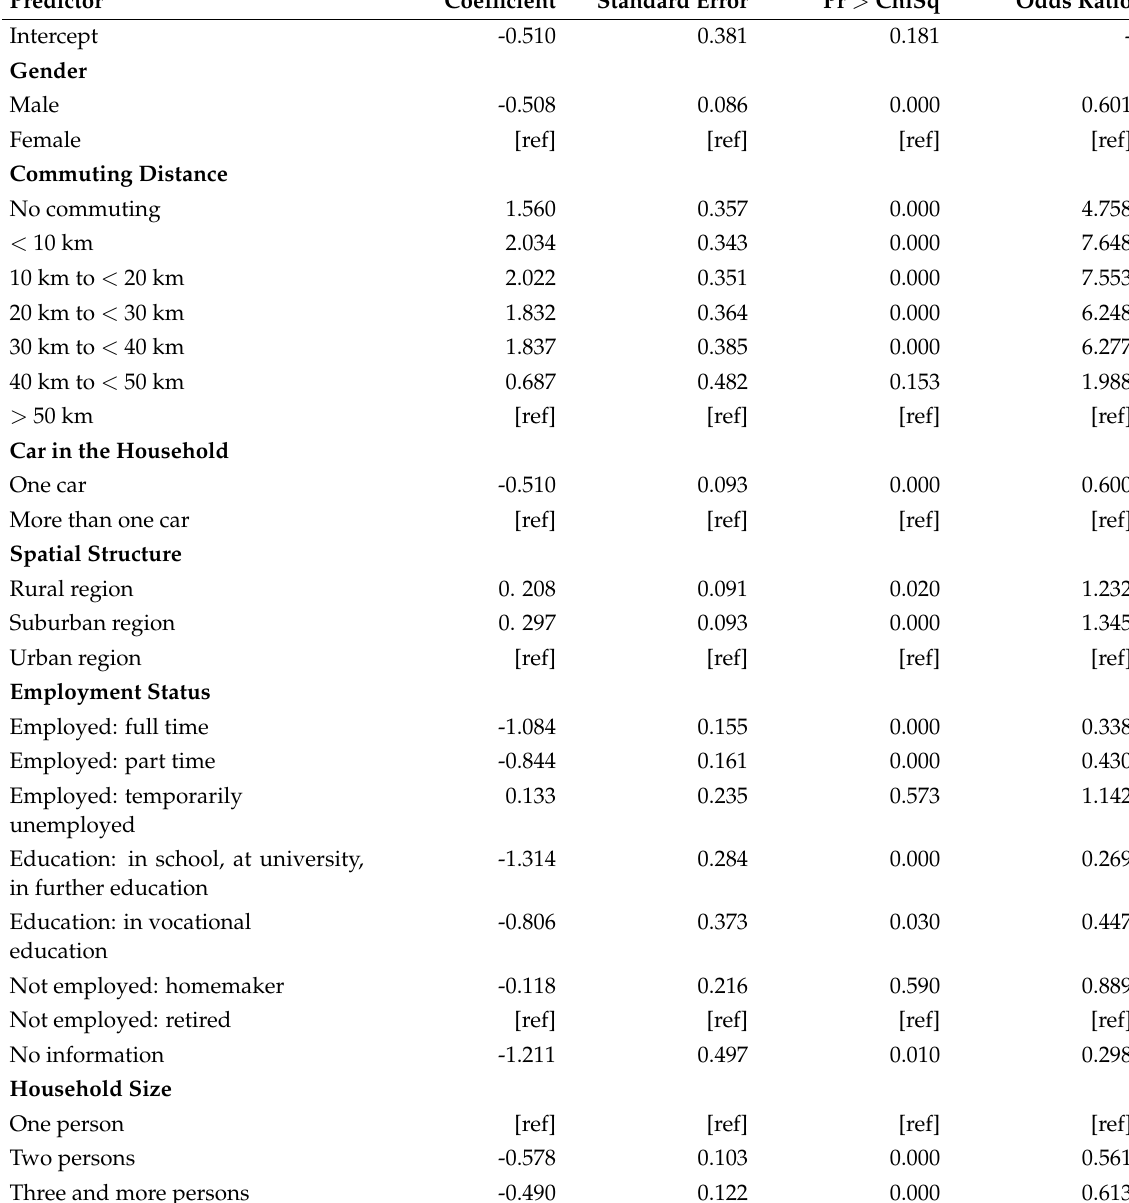
Table 2. Logit model estimation results for the EV suitability model. Database: CUMILE . Probability that a car is driven more than 90 km/day on 12 or fewer days per